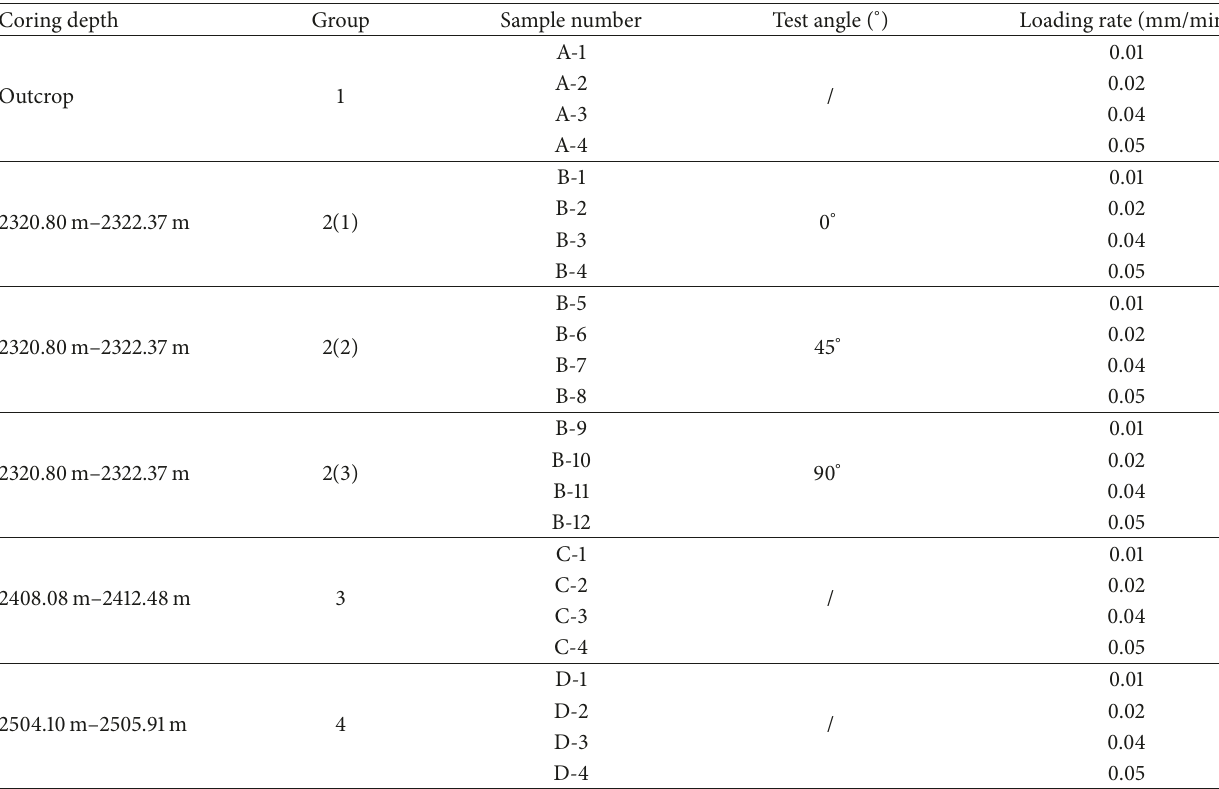
Table 1: Experimental